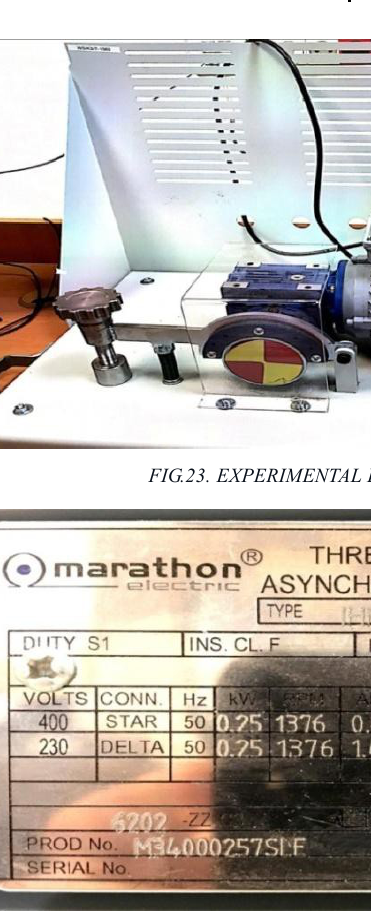
FIG. 25. CONTROLLER